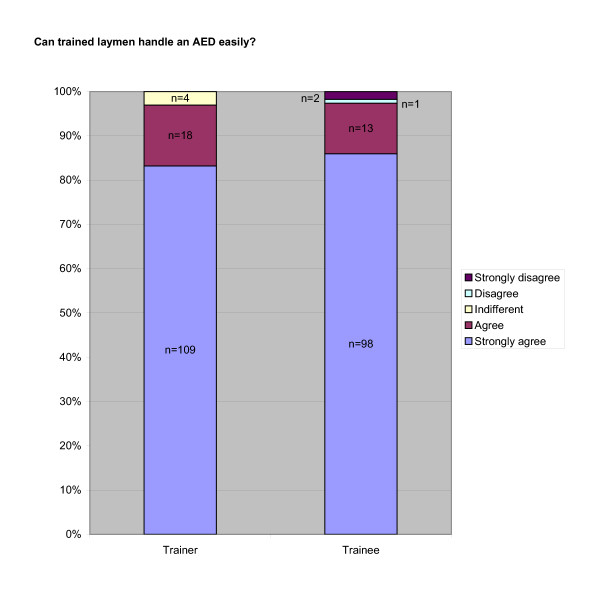
Can trained laymen easily handle an AED?. The trainer (student) rated how easy it was for the trainee (patient) to use an AED. The trainee (patient) rated how easy it was for him to use an AED. ("The participants believe that the usage of an AED is easy."/"I believe that the usage of an AED is easy.").